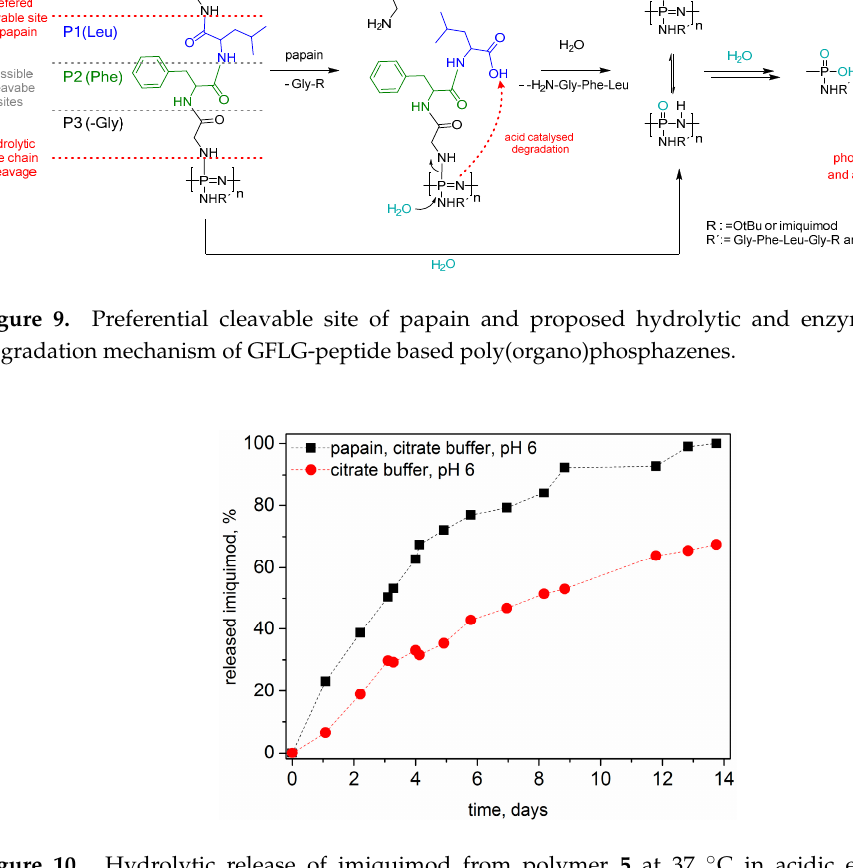
Figure 10. Hydrolytic release of imiquimod from polymer 5 at 37 °C in acidic environment (citrate bu ff er, pH 6) ( ● ), and enzymatic release of imiquimod from polymer 5 at 37 °C in the same buffer with L-cysteine activated papain ( ■ ) . The amount of the released drug was estimated using a calibration curve for the free drug.